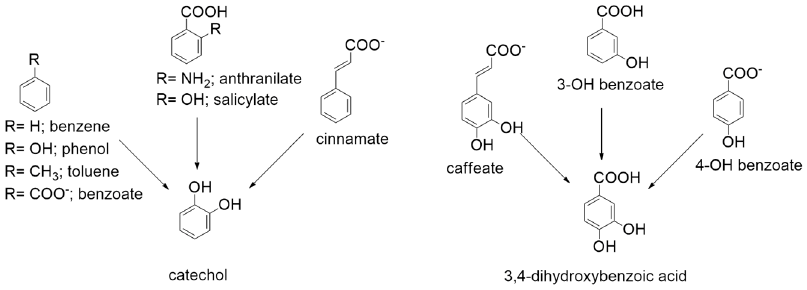
Figure 4. Examples of microbial “channelling aerobic pathways” for the production of aromatic central intermediates [30]. Adapted with permission from [30]. Copyright 2011, Springer Nature.